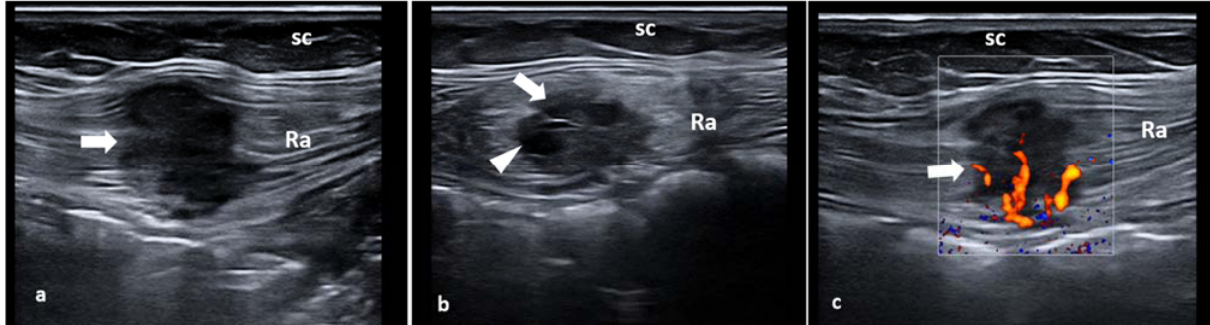
Figure 7. Long ‐ axis sonograms show a hypoechoic, nodular mass inside the rectus abdominis with speculated borders ( a ). Short ‐ axis sonograms show a partially cystic nodular (hypo ‐ anechoic) mass with ill ‐ defined margins ( b ). Fine intralesional vascular spots are depicted with color ‐ power Doppler ( c ). sc : subcutaneous tissue ra : rectus abdominis muscle.